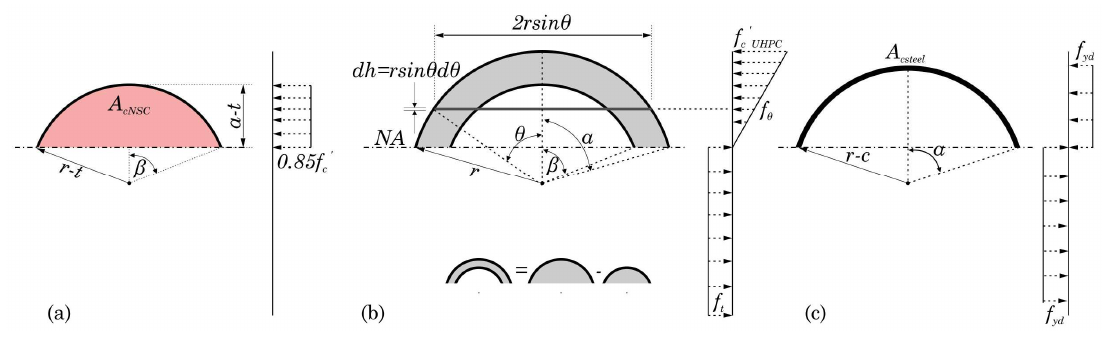
Figure 2. Diagram for calculation of forces in ( a ) substrate concrete, ( b ) UHPC shell, and ( c ) steel reinforcement.